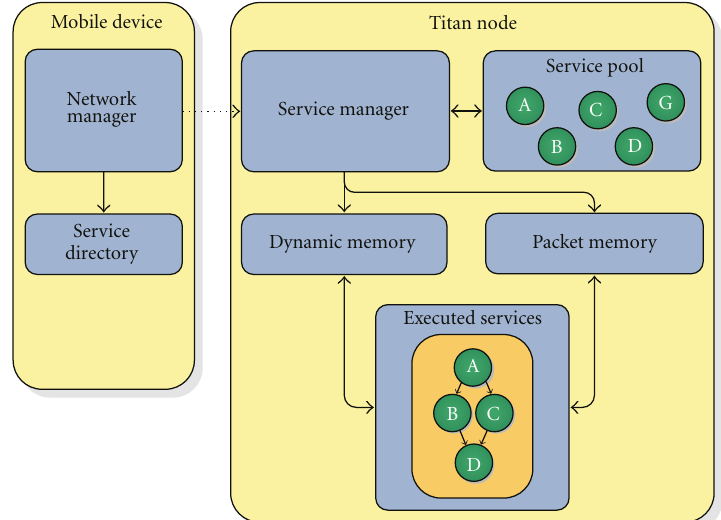
Figure 3: Main modules of the Titan Nodes (right). The arrows indicate in which direction functions can be called. The network manager in the mobile device can control the instantiation of service graphs by communicating with the Service Manager of the Titan Node.